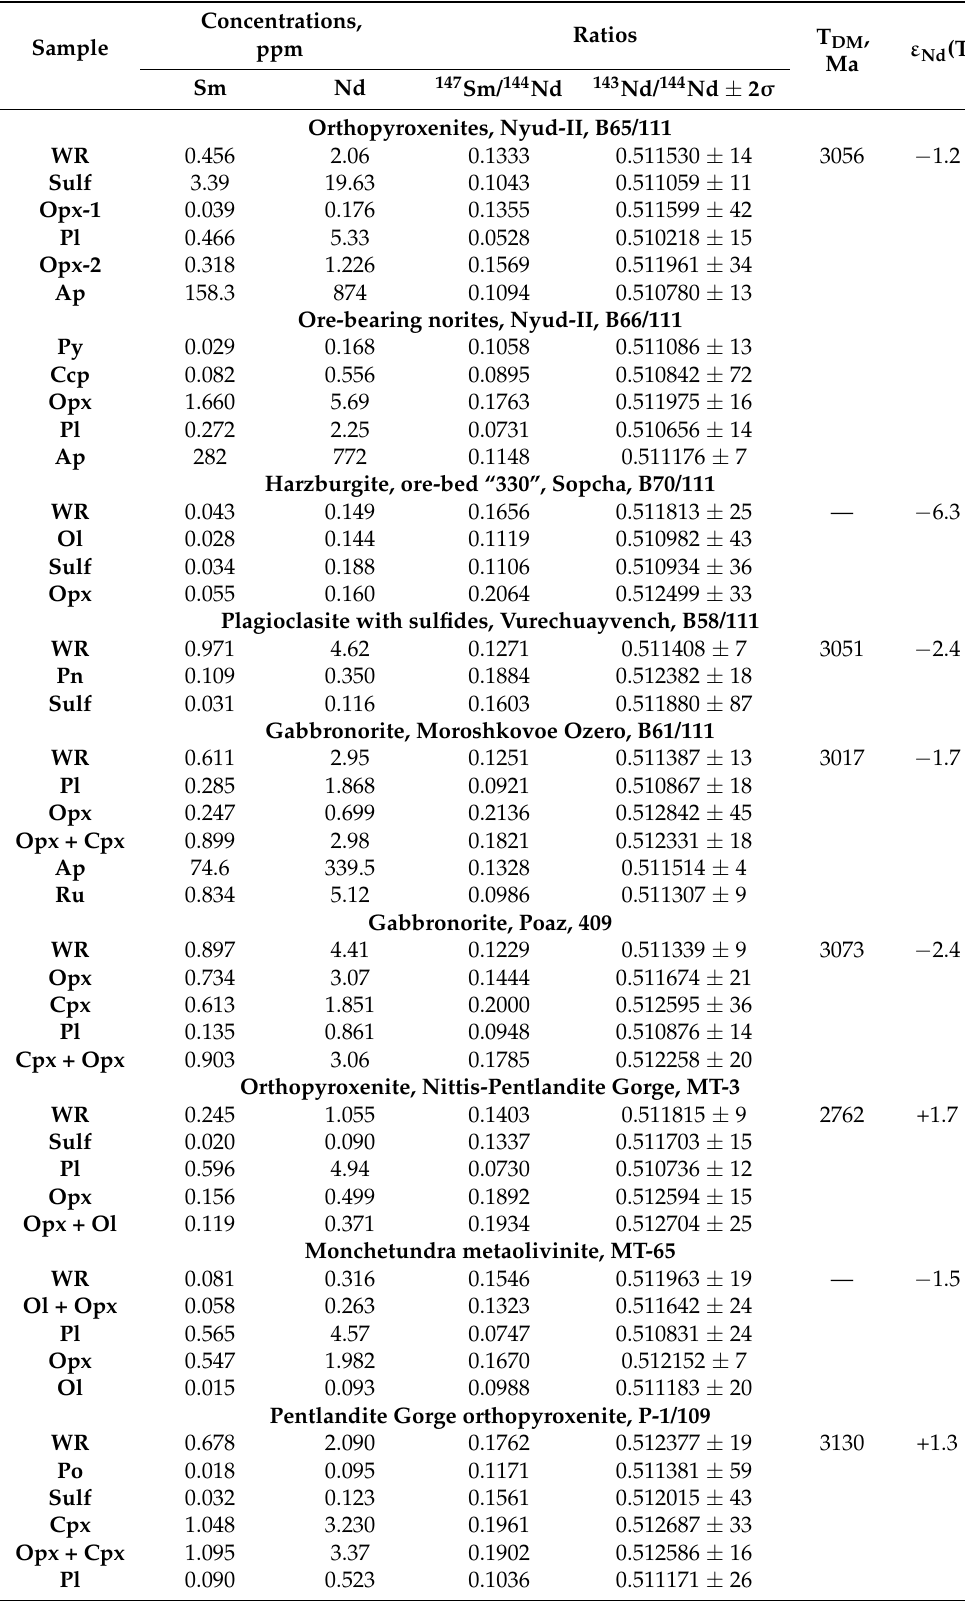
Table 2. Sm-Nd data for rocks and minerals of Monchegorsk